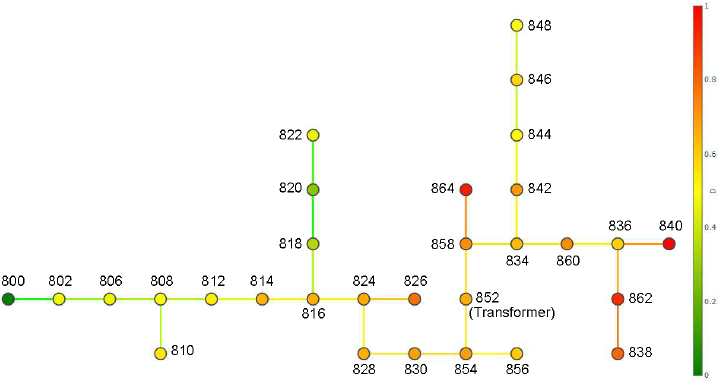
Figure 19. D function graphical representation for Base Case 2.